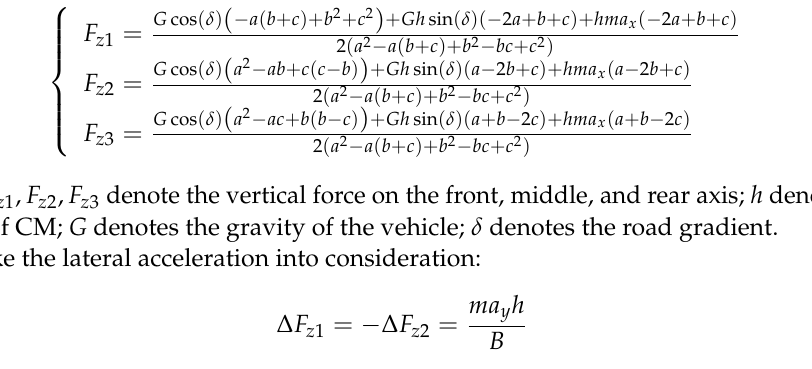
Figure 5. Lateral forces calculated by the Brush model.